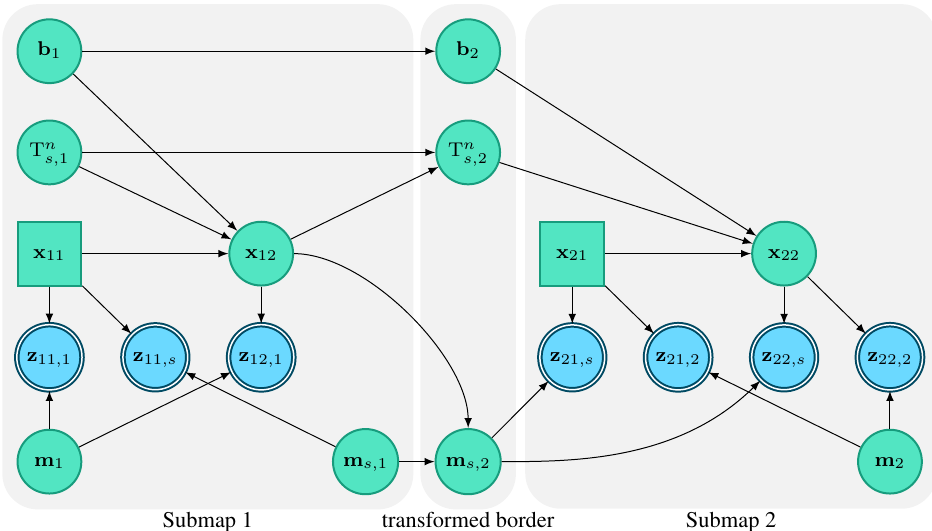
Figure 1. Dependencies between nodes in the Bayesian network corresponding to the SLAM problem before performing marginal- ization with the Schur complement. Green nodes with a single boundary are state variables. Rectangular green nodes represent states which are held fixed during optimization to impose the gauge constraints. Blue nodes with a double boundary represent measurements (landmark observations). Inertial measurements and velocities are not shown in this simplified